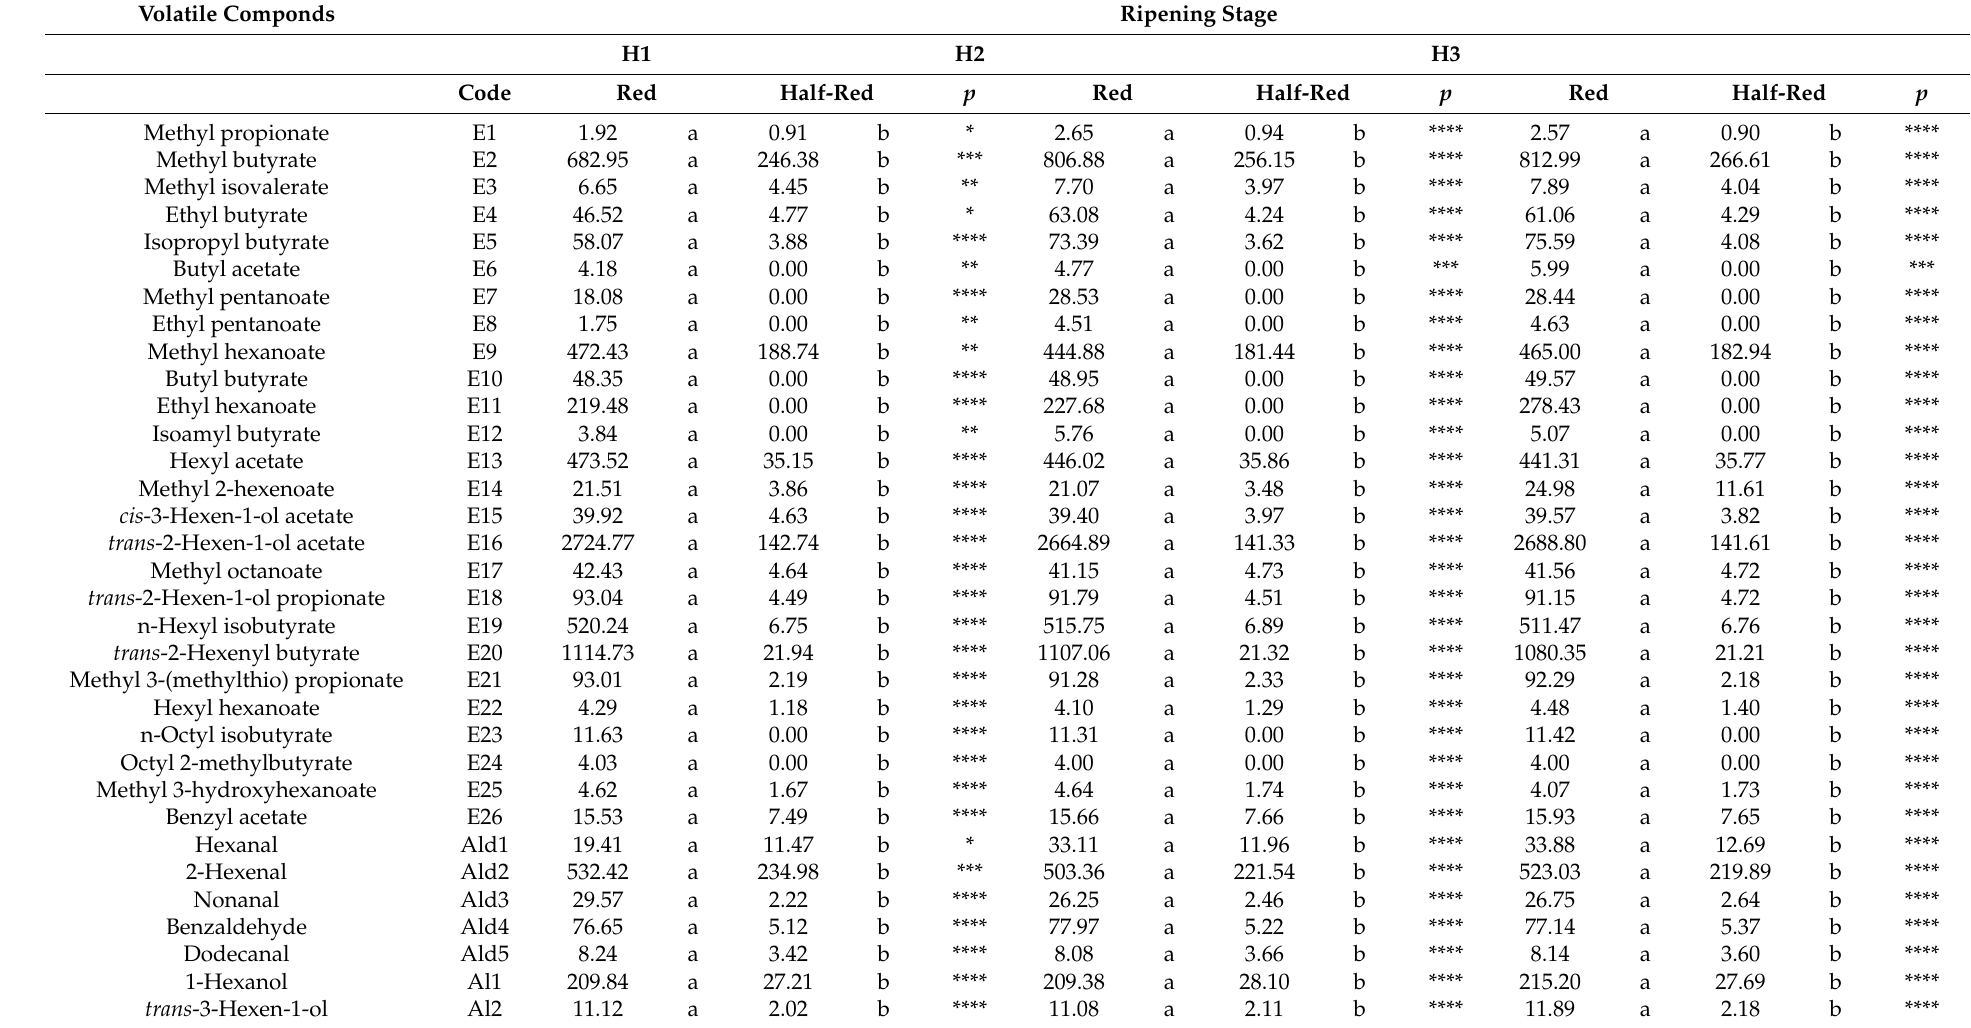
Table 3. Volatile compounds obtained in strawberries cv “Sabrosa” at two different ripening stages (half-red or red) and at three harvest times (H1, H2,